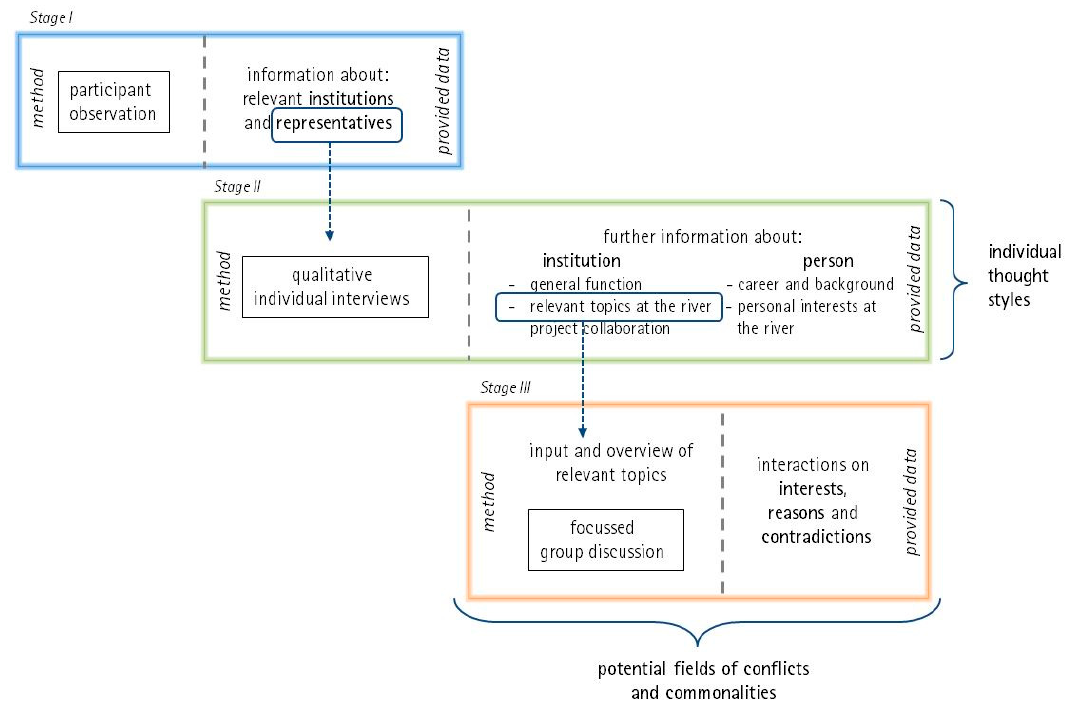
Figure 2. Three-stage research design for stakeholder analysis on the multi-level and potential outputs.